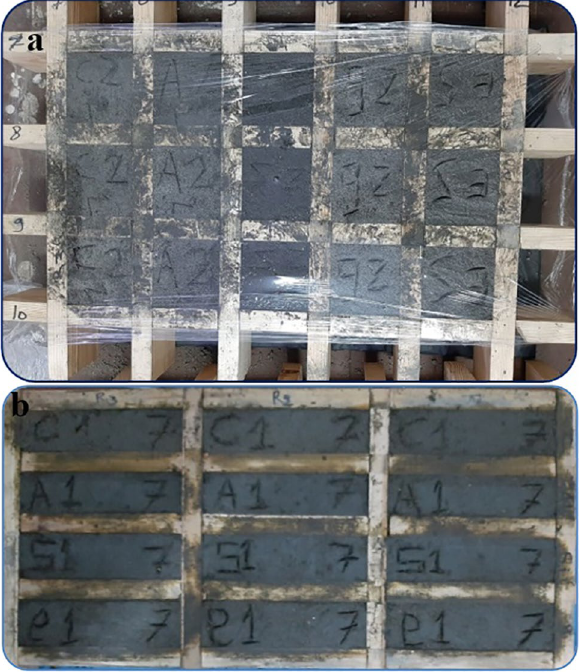
Figure 10. Cube wood molds containing the mortar ( a ), Prisms ( b ); Cement: sand = 1:3, Ash/Cement = 0.1, Bacterial culture/cement =